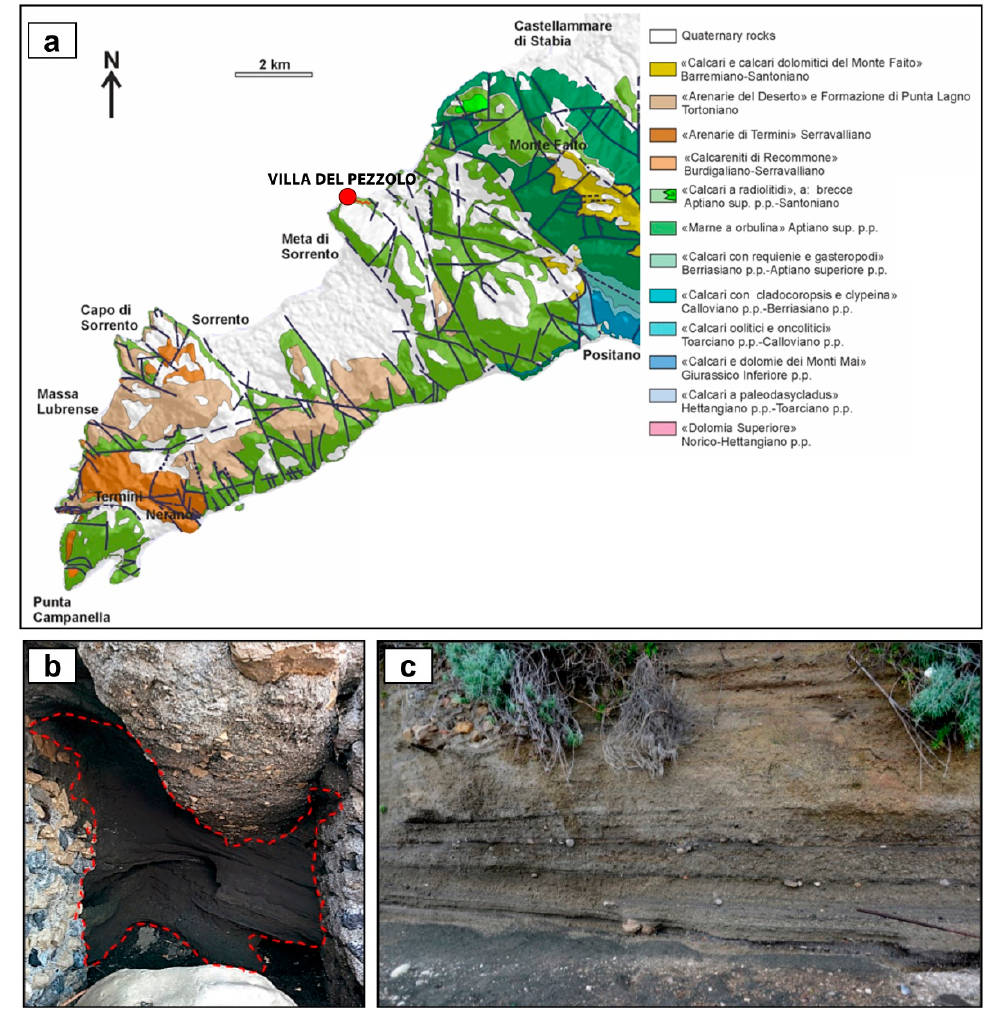
Figure 2. ( a ) Geological sketch map of Sorrento Peninsula (modified after [17]); ( b ) evidence of A.D. 79 eruption: base surge of Somma-Vesuvius volcano (~12 km far); ( c ) “Durece” deposit, typical lithofacies of reworked pyroclastic